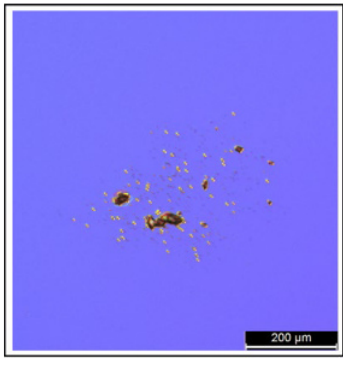
Fig. 3 DIC microscopy image of the investigated damage site of the SiO 2 coated sample (355 nm LIDT). The site was irradiated with an energy density of 9.8 Jcm -2 .